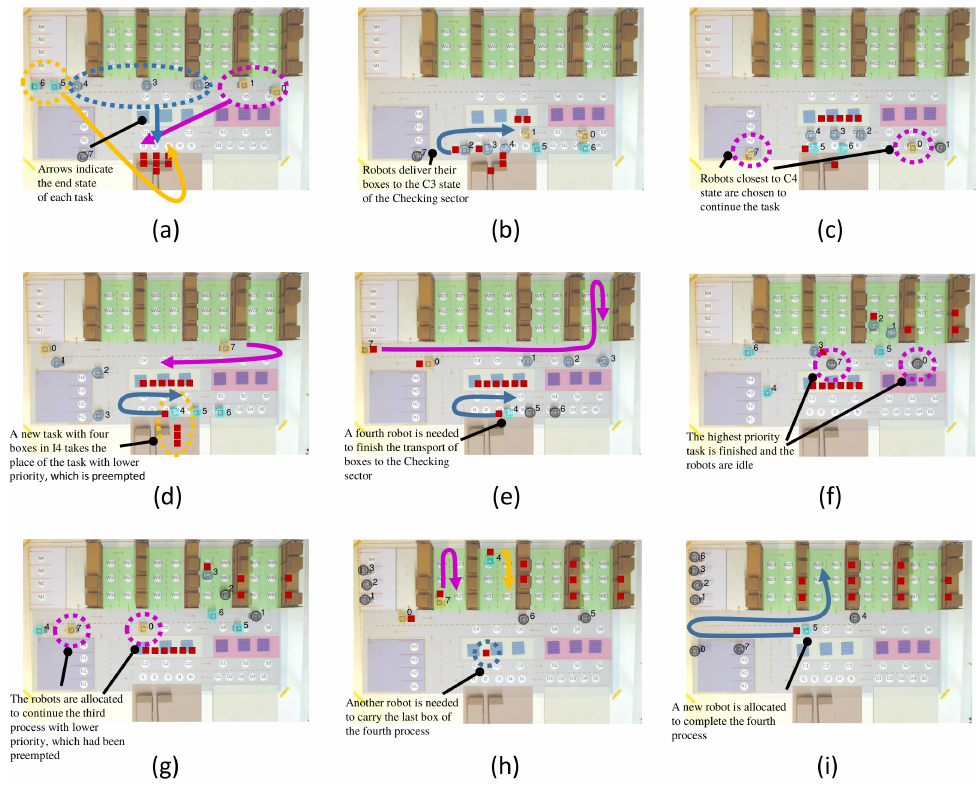
Figure 9. Main scenes from experiment 2: Preemption. Scene ( a ) being the initial, scene ( i ) the final and scenes ( b – h ) the